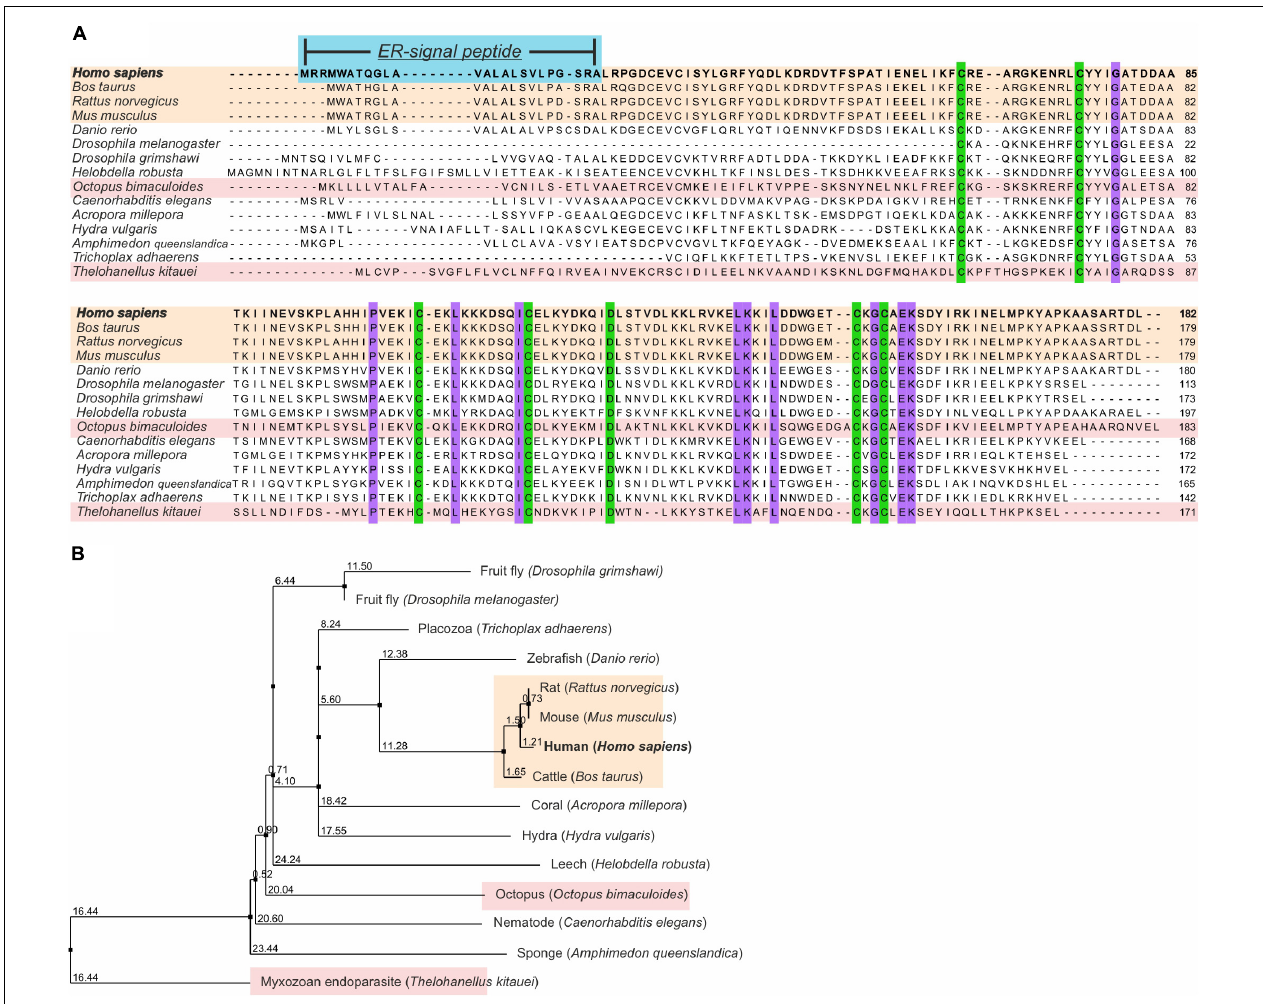
FIGURE 2 | Phylogenetic analysis of MANF. (A) Vertebrate MANF orthologs (cream boxes) were obtained by NCBI, as calculated by NCBI’s Eukaryotic Genome Annotation pipeline for the NCBI Gene dataset. Non-vertebrate MANF orthologs were obtained with the NCBI “similar gene” pipeline. For two of the metazoans presented (pink boxes), human protein sequence was blasted in the EnsemblMetazoan database (metazoa.ensembl.org). Protein sequences were aligned using ClustaOWS in Jalview v. 2.10.5 (Clamp et al., 2004). Conserved amino acids in all organisms are highlighted in purple or green for cysteines. Numbers denote the amino acid number. (B) Phylogenetic tree of MANF is based on protein sequence similarity. It was calculated from distance matrices determined from % identity using the neighbor joining algorithm. Each number is a score, and each branch is an additive allowing for comparison of distances in the tree branches. Used sequence IDs: Homo sapiens (T1FAB3) , Bos Taurus (Q9N3B0) , Rattus norvegicus (A0A0C2MNP5) , Mus musculus (A0A0L8FVI8) , Danio rerio (B3RIB4) , Drosophila grimshawi (B4JT39) , Drosophila melanogaster (Q9XZ63) , Helobdella robusta (Q3TMX5) , Octopus bimaculoides (P55145) , Caenorhabditis elegans (P80513) , Acropora millepora (F1QDQ5) , Hydra vulgaris (B2RZ09) , Amphimedon queenslandica (T2MFG7) , Trichoplax adhaerens (A0A1 × 7TYG8), and Thelohanellus kitauei